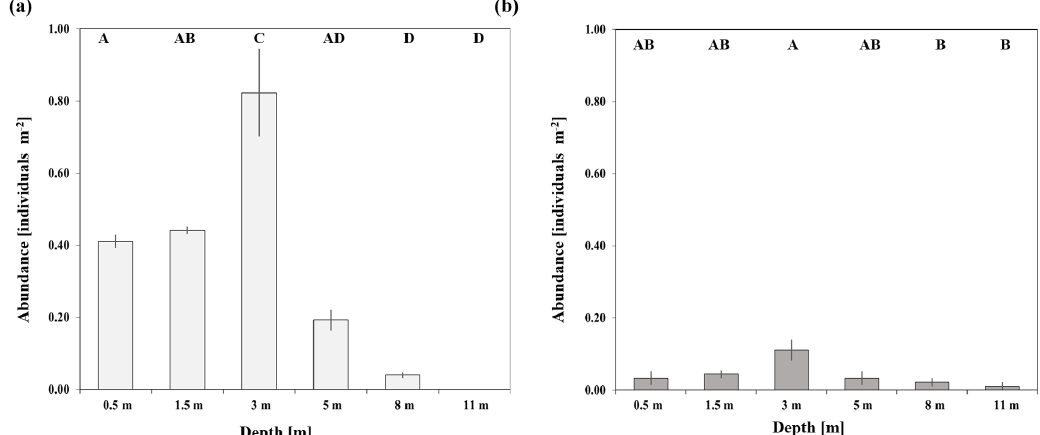
Figure 2. Changes in the abundance (individualsm − 2 ± SD) of T. maxima with depth at a sheltered reef (a) and an exposed reef (b) in the central Red Sea. Different capital letters describe statistically significant differences in abundance between survey